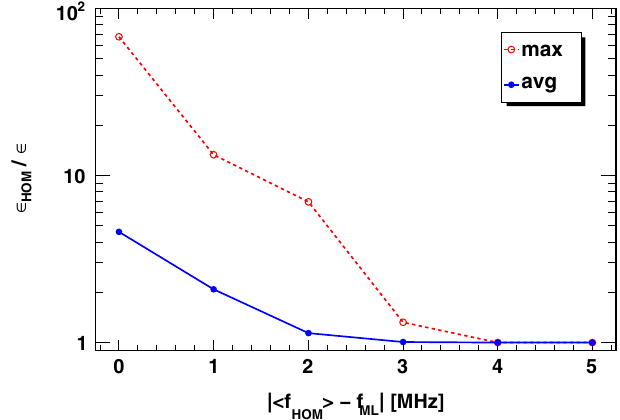
FIG. 12. Average (solid, blue) and maximum (dashed, red) longitudinal phase space increase as a function of the distance to 4th machine line. Settings: h f N ¼ 100 , see Table